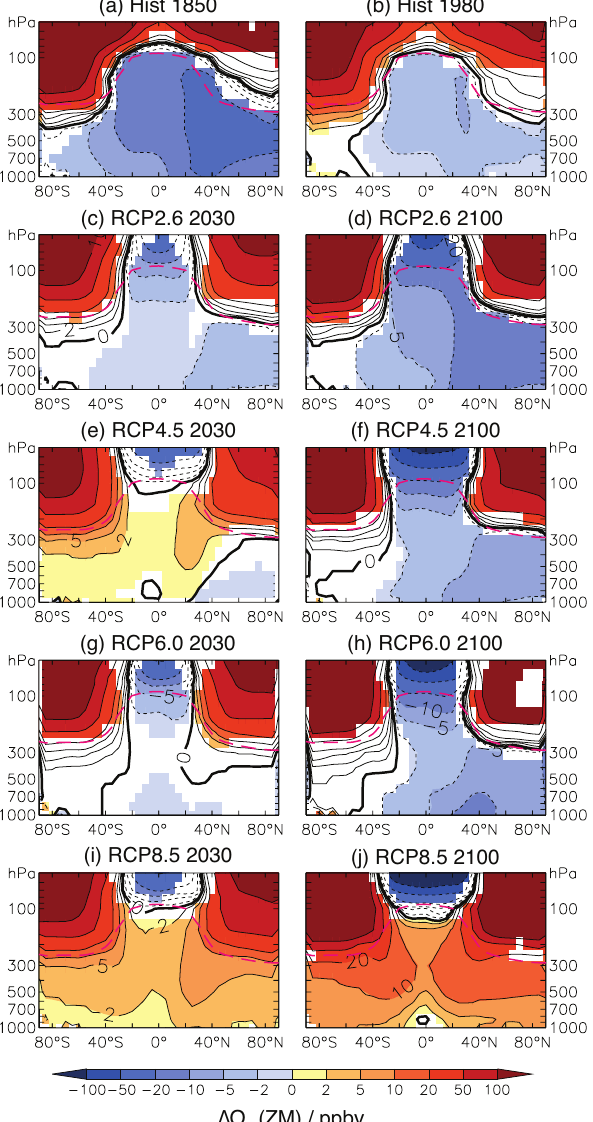
Fig. 10. As Fig. 9, but for the absolute change in the tropospheric ozone column